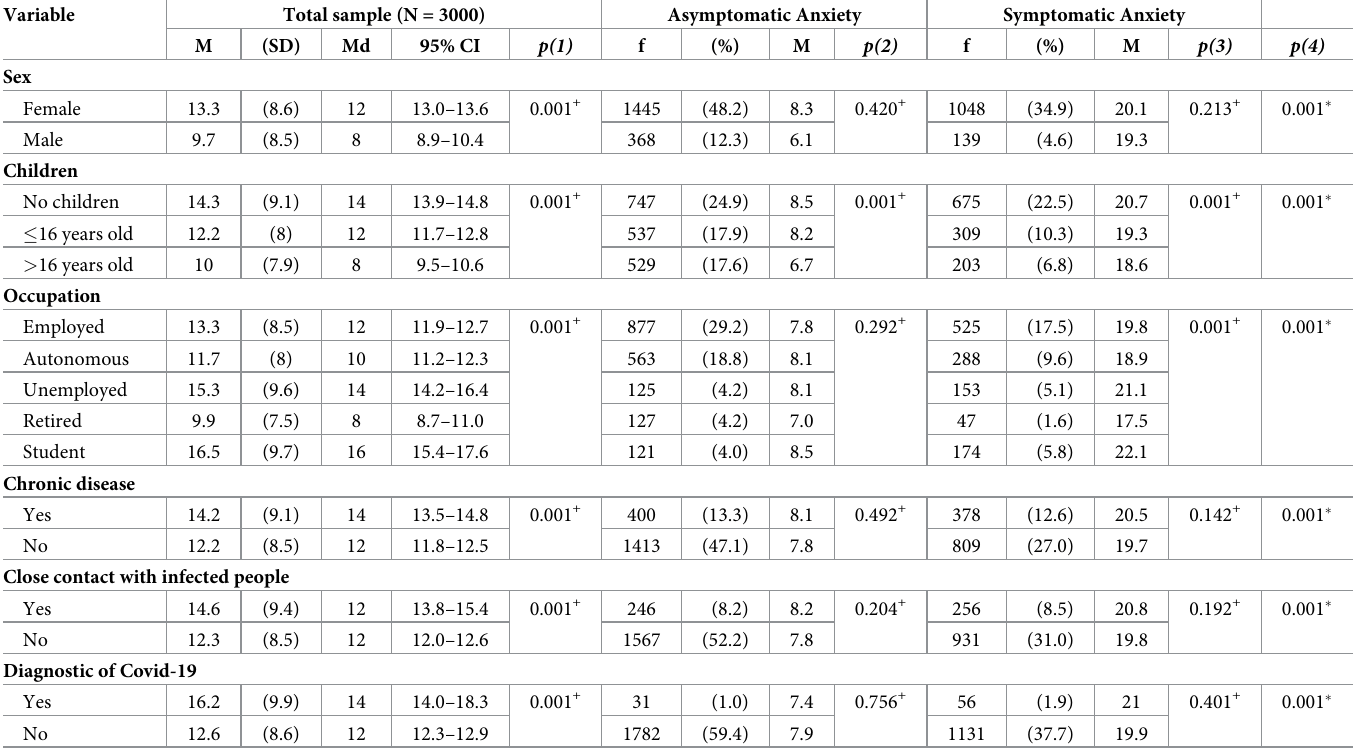
Table 4. Comparison of symptomatic and asymptomatic groups for anxiety. Total sample (N =